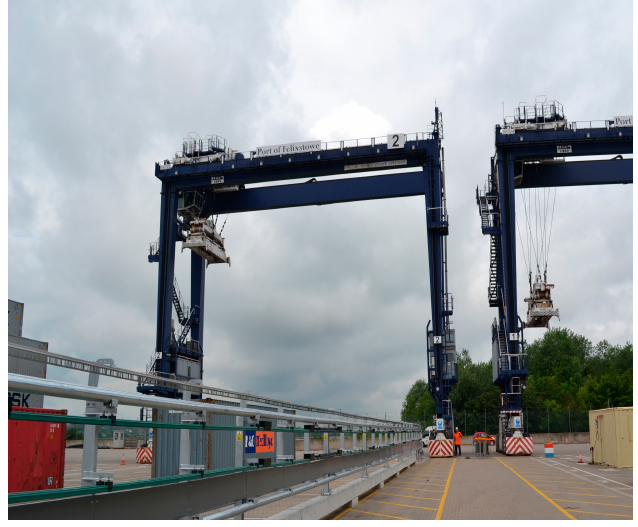
Figure 1. An electrified Rubber Tyre Gantry (RTG) crane at the Port of Felixstowe, UK